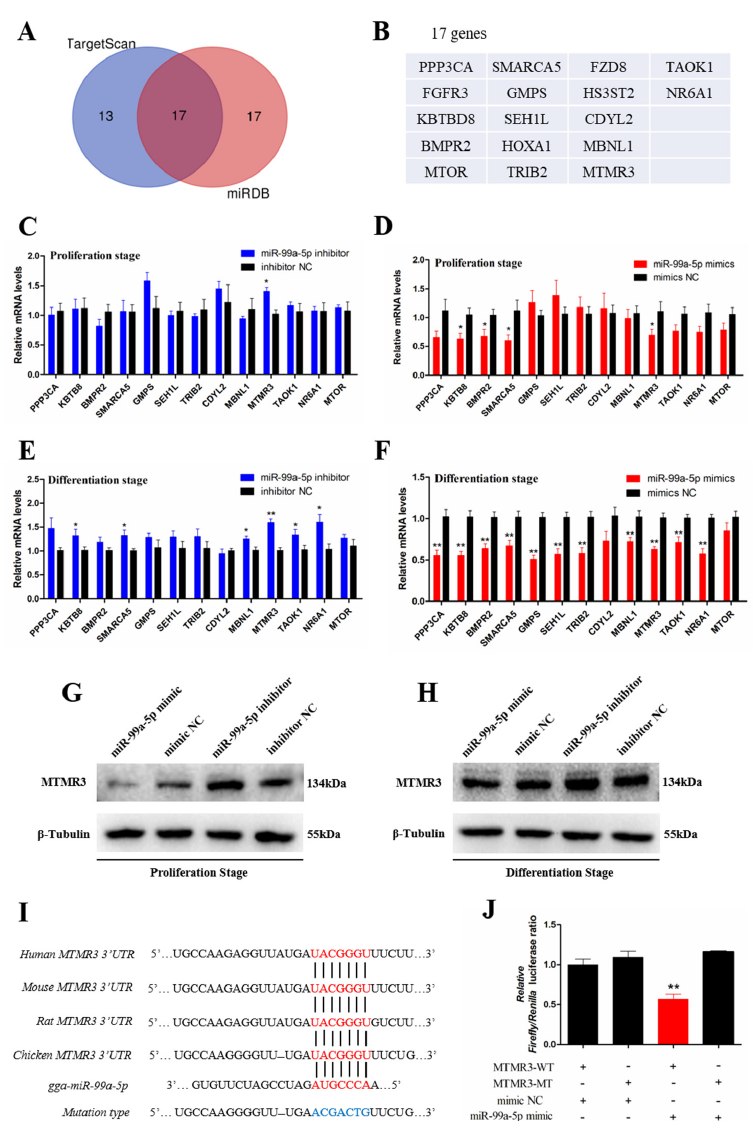
Figure 4. Target gene scanning revealed that miR-99a-5p directly target the myotubularin-related protein 3 (MTMR3) gene. ( A ) Venn analysis of miR-99a-5p target gene prediction results from TargetScan and miRDB websites. ( B ) Seventeen target genes of miR-99a-5p (the intersection of Venn analysis results) are listed. ( C, D ) Thirteen target genes of miR-99a-5p were detected by qRT-PCR in SMSCs after overexpression and inhibition of miR-99a-5p in the proliferation stage. ( E, F ) Thirteen target genes of miR-99a-5p were detected by qRT-PCR in SMSCs after overexpression and inhibition of miR-99a-5p in the differentiation stage. ( G ) The protein level of MTMR3 were detected by Western blotting in undifferentiated SMSCs after overexpression and inhibition of miR-99a-5p. ( H ) The protein level of MTMR3 was detected by Western blotting in differentiated SMSCs after overexpression and inhibition of miR-99a-5p. ( I ) The conserved miR-99a-5p binding site in the MTMR3 mRNA 3 ′ untranslated region (UTR). The seed sequence and mutant sequence in miR-34b-5p are highlighted in red and blue, respectively. ( J ) The dual-luciferase reporter assay was performed in DF-1 cells that co-transfected with wild-type or mutant MTMR3 3 (cid:48) UTR with miR-99a-5p mimic or mimic NC. Results are shown as mean ± SEM, and the data are representative of at least three independent assays. Student’s t -test were used to compare expression levels among di ff erent groups. * p < 0.05; ** p <